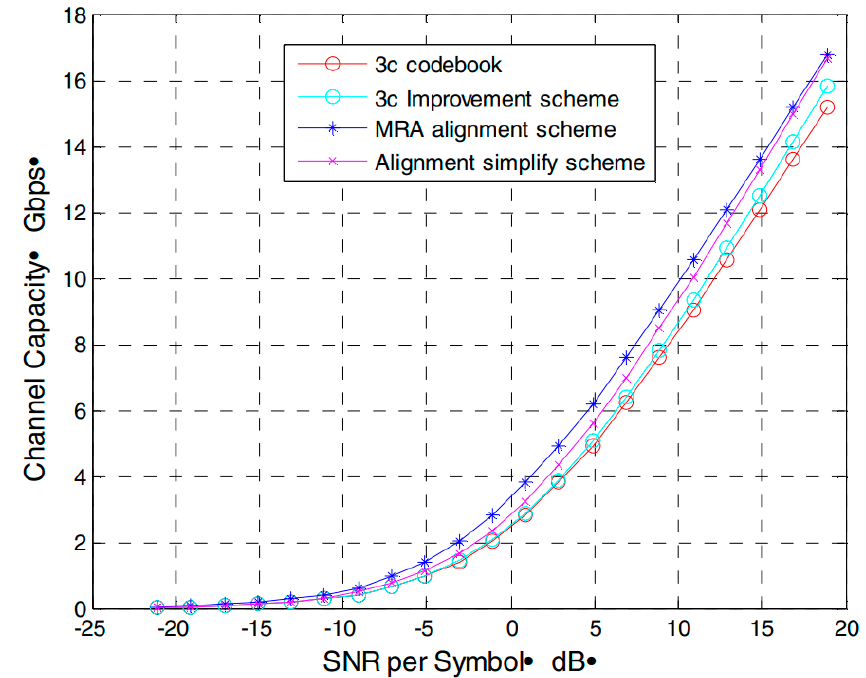
Figure 10. Point-to-point capacity analysis [49].